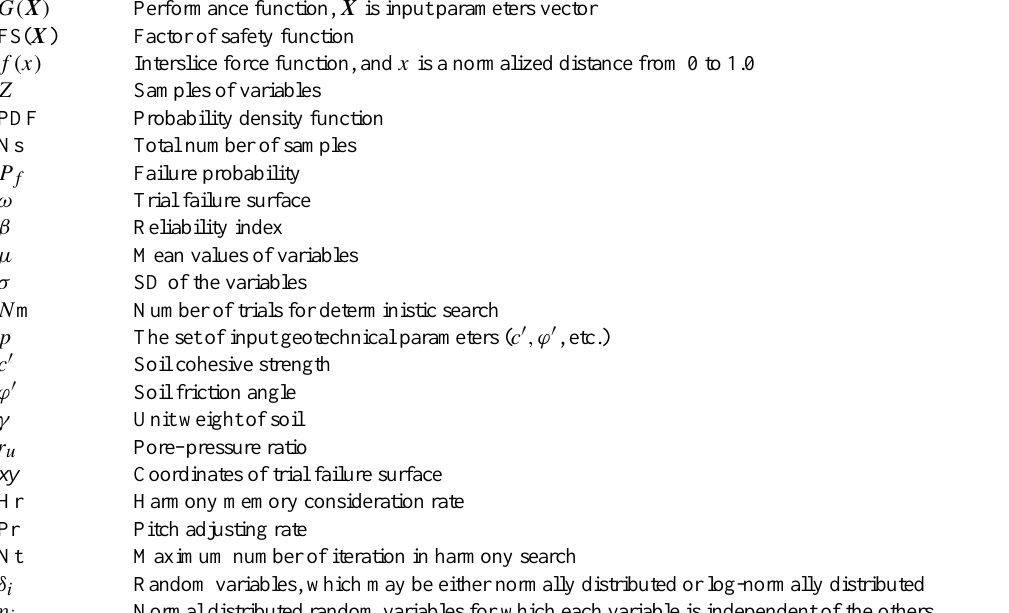
Table A1. List of